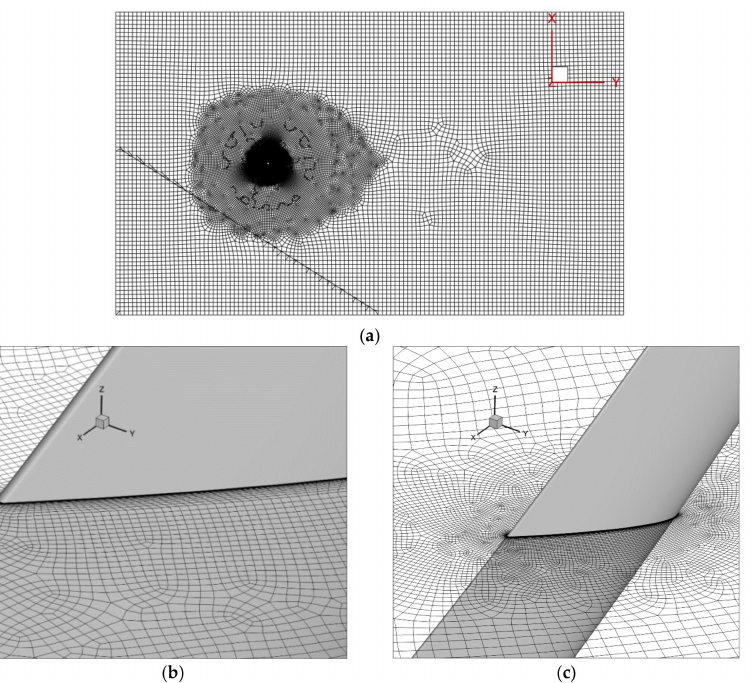
Figure 3. ( a ) Sectional view of the domain mesh: ( b ) mesh near the blade, ( c ) mesh growth surround- ing the